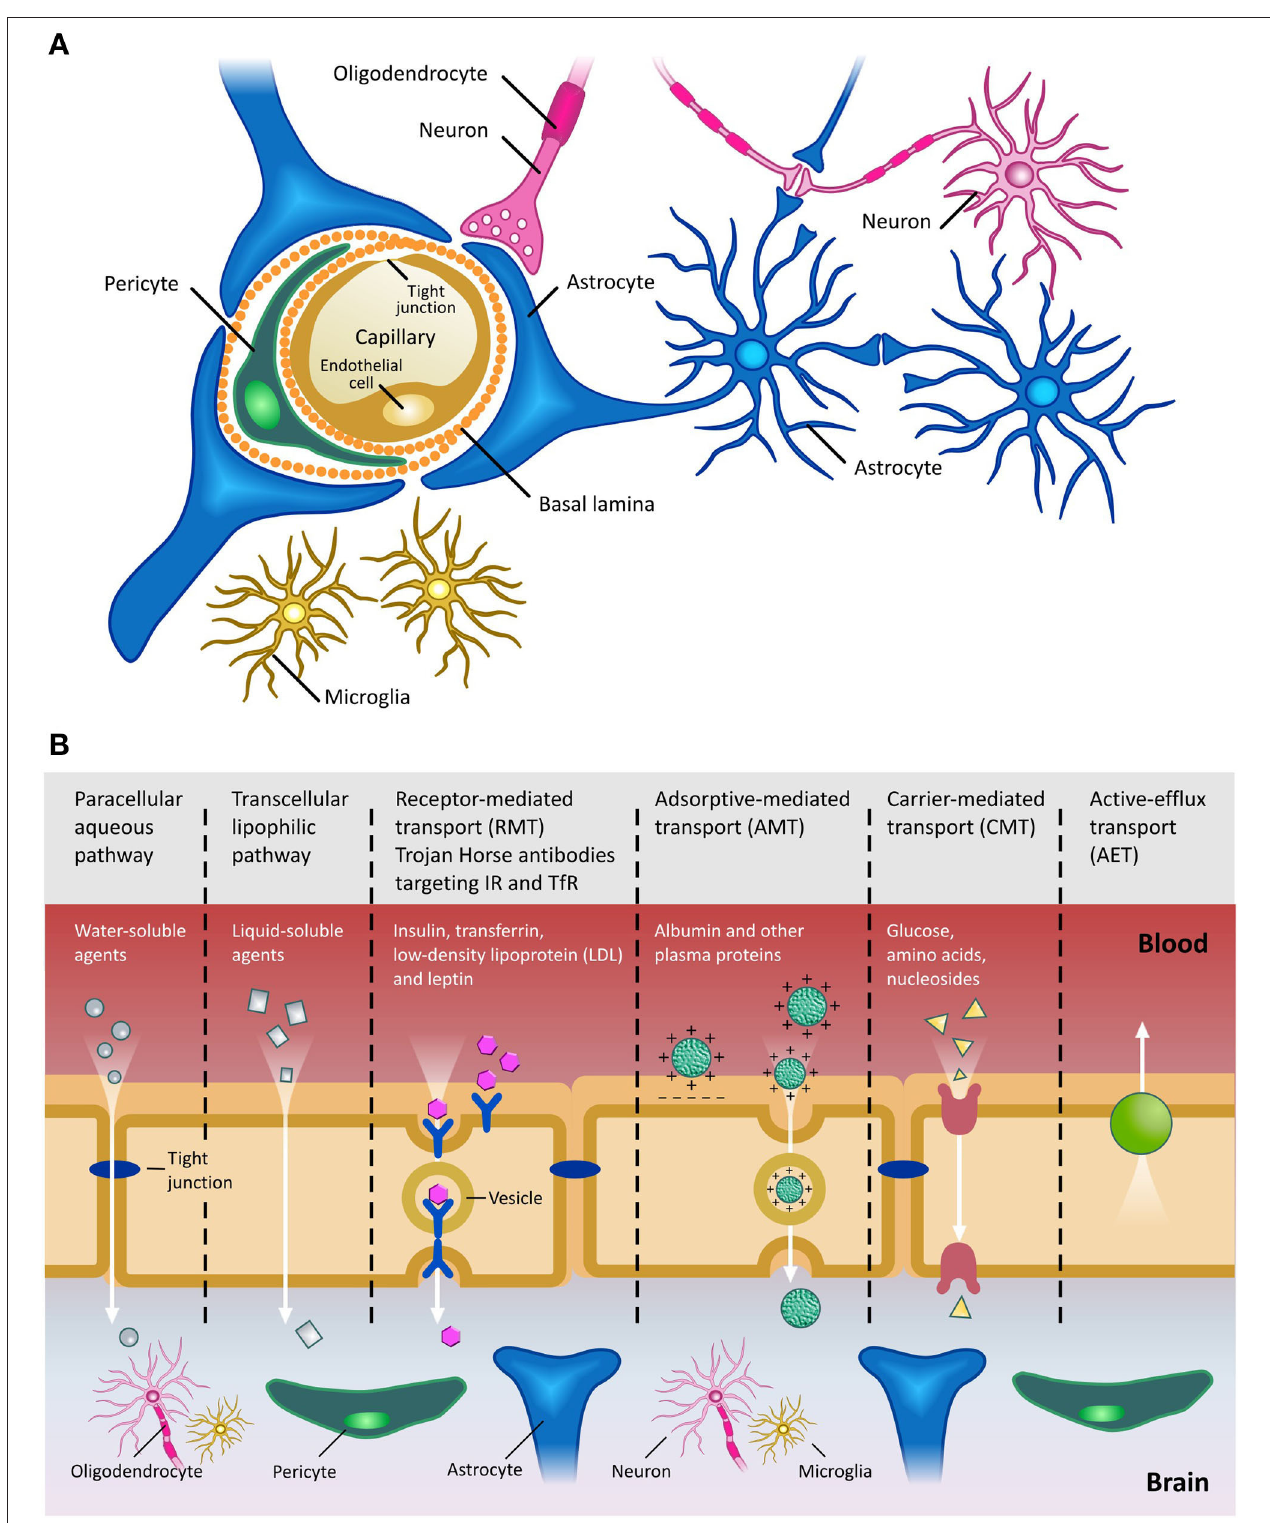
FIGURE 2 | The Blood Brain Barrier. (A) Schematic of the BBB shown in cross-section. Main cellular components are shown. Endothelial cells are fused together by tight junctions, and surrounded by pericytes and astrocytic end feet. Figure adapted from (59). (B) Transport pathways across the Blood Brain Barrier. Ions, water and other small molecules necessary to maintain CNS homeostasis (such as glucose for metabolic support) can cross the BBB using a variety of mechanisms, including those based on passive diffusion, from high to low concentrations, and active transport, requiring ATP hydrolysis. Molecules can cross the BBB using